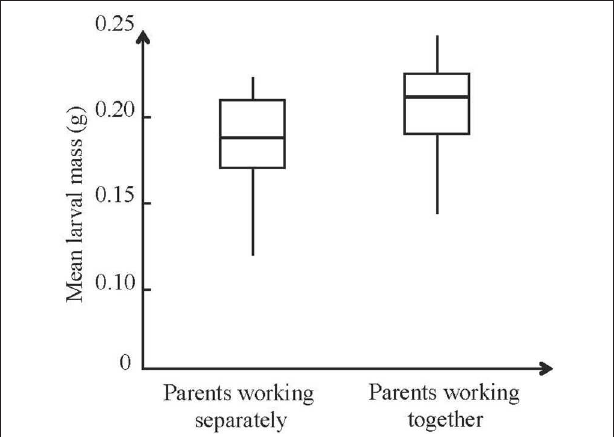
FIGURE 2 | Effects male and female parents working separately or together on larval fitness. Larvae reared by parents working together were heavier at the time of dispersal from the carcass than larvae reared by parents working separately in the burying beetle Nicrophorus vespilloides (LR χ 2 1,86 = 11:18, p < 0.001). Box plot where the thick central line denotes the median, the box the 25th and 75th percentile, and the whiskers denote the 10th and 90th percentiles. Used with permission from Royal